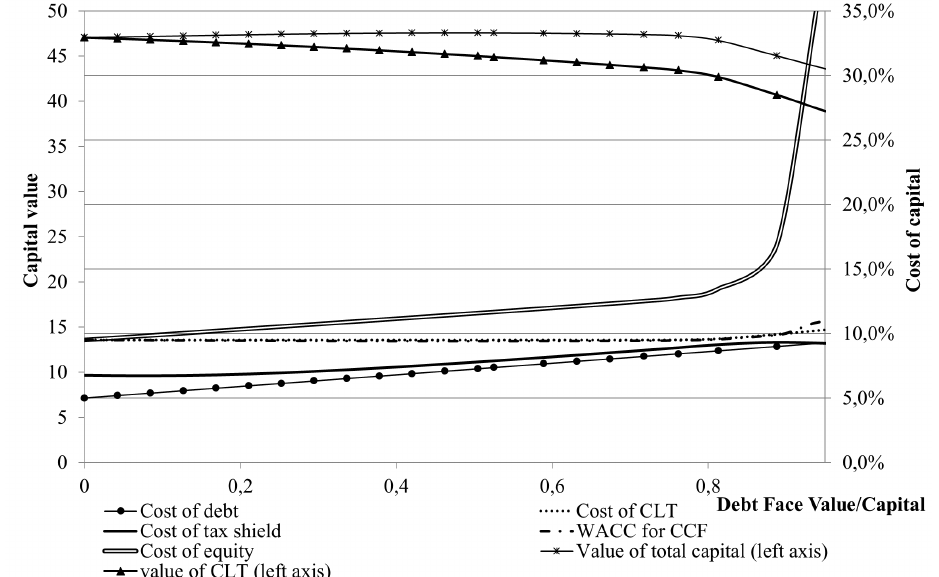
Fig. 1. Low-growth-low-risk companies with tax optimization g = 1%, t t = 10%, b =